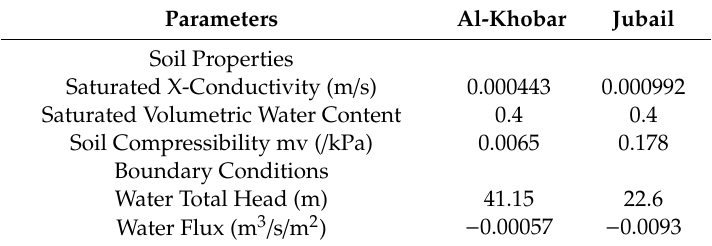
Figure 10. Numerical model: Mesh and boundary conditions for the ( a ) Al-Khobar and ( b ) Jubail sites. Table 7. Model